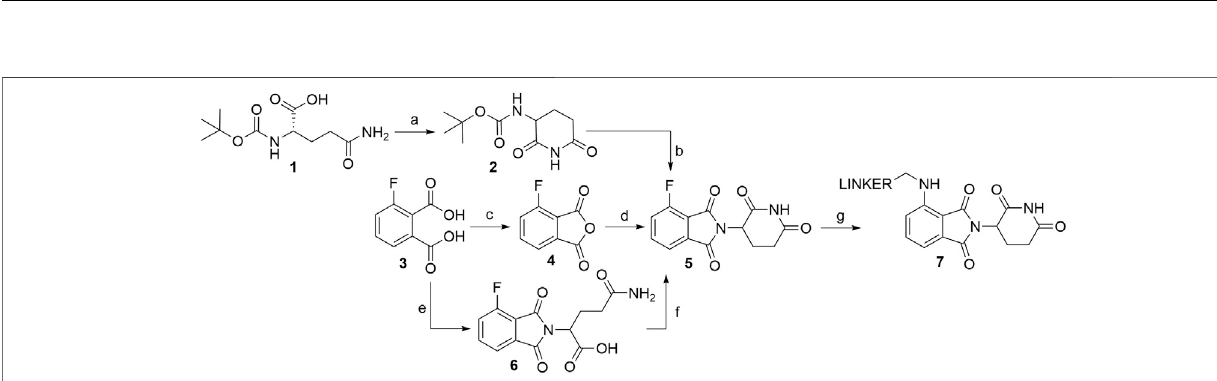
FIGURE 2 | Commonly utilized thalidomide-derived CRBN ligands and possible linker attachment styles. (A1 – A2) pomalidomide derivatives; (B1 – B2) 4-hydroxythalidomide derivatives; (C1) alkyl type attachment to thalidomide; (D1 – D3) lenalidomide derivatives.